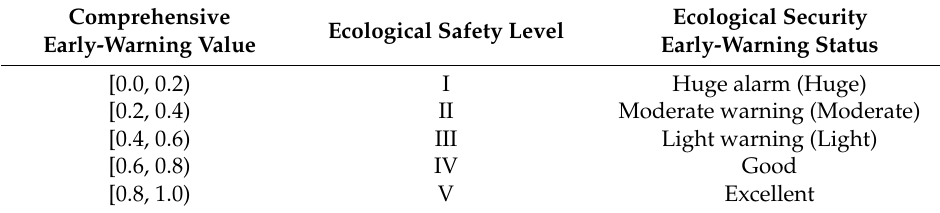
Table 1. The ecological security early-warning